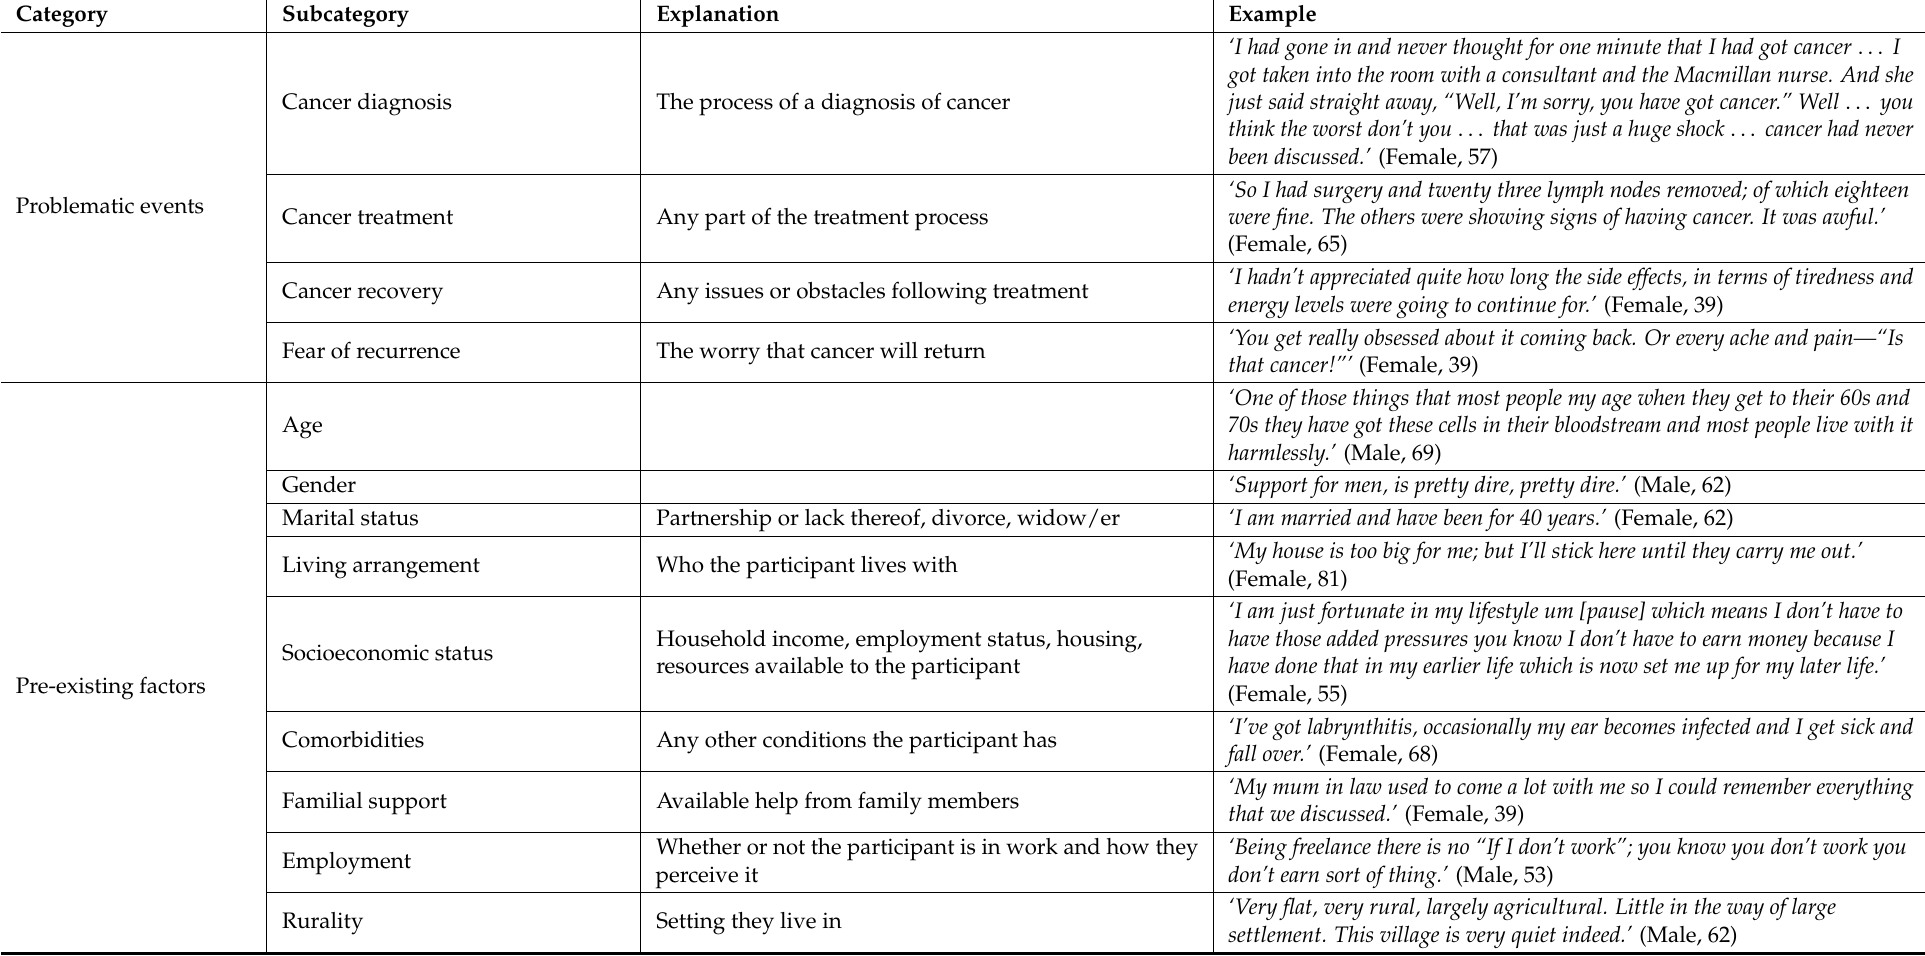
Table 3. Contributing factors in the recovery of subjective health and wellbeing during cancer